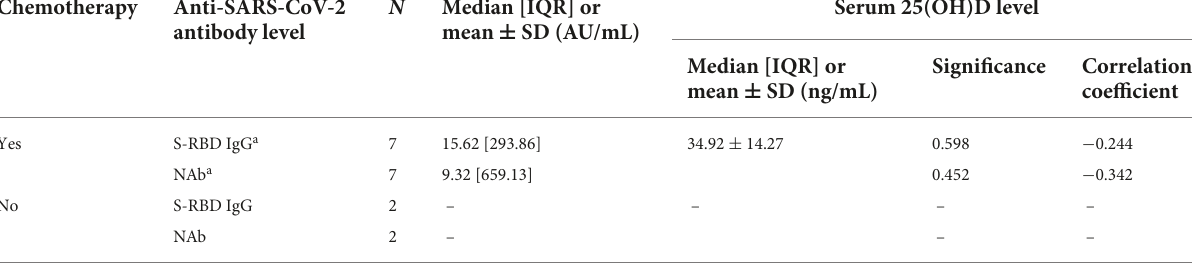
TABLE 6 The correlation between serum 25(OH)D levels and anti-SARS-CoV-2 antibody (anti-SARS-CoV-2 S-RBD IgG and NAb) among hematologic malignancies subjects received chemotherapy and non-chemotherapy.